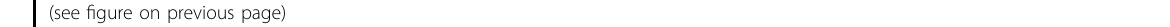
Fig. 2 Experimental results of a resonant radial metalens with NA = 0.2. a Illustration showing the resonant operation of the metalens, with ‘ green ’ light being focused, while the other colors are passed without distortion. b Photograph of the metalens with a diameter of 800 μ m. c Scanning electron microscope (SEM) images of the device at its center (top) and edge (bottom). d Schematic of a meta-unit of a p2 plane group, generated by applying a dimerization perturbation of magnitude δ to a square lattice of square apertures. e Simulations showing that the geometric phase Φ of light of converted handedness of circular polarization is approximately four times of the orientation angle α of the dimerizing perturbation. f Spectra of transmitted light with converted handedness of circular polarization of meta-units with A = 450 nm, L = 175 nm and δ = 50 nm (dark red), L = 200 nm and δ = 75 nm (red), L = 225 nm and δ = 100 nm (orange), L = 250 nm and δ = 125 nm (green), and L = 275 nm and δ = 150 nm (blue) de fi ned in a 125 nm thick silicon thin fi lm, showing that Q-factors vary from 3200 (dark red) to 85 (blue). g Measured transmission spectra of the metalens for light of converted and unconverted handedness of circular polarization. h Measured transverse intensity distributions on the focal plane. i Measured longitudinal intensity distributions on a plane through the focal spot. The metalens is located at Z = 0. j Measured (solid red curves) and theoretical (black dashed curves) linecuts of the focal spot at the center of the resonance, λ = 1590 nm, along the x and y directions. k Simulated resonant wavelength dispersion as a function of refraction angle for phase-gradient nonlocal metasurfaces excited by normally incident light. Dots represent the center of a resonance and shaded regions FWHM of the resonance. Data for the cases in which the phase gradients are orthogonal to the direction of dimerization perturbation are shown in red and those for the cases in which the phase gradients are along the direction of the perturbation are shown in blue. Inset: Schematics illustrating the two alignments between the phase gradient and